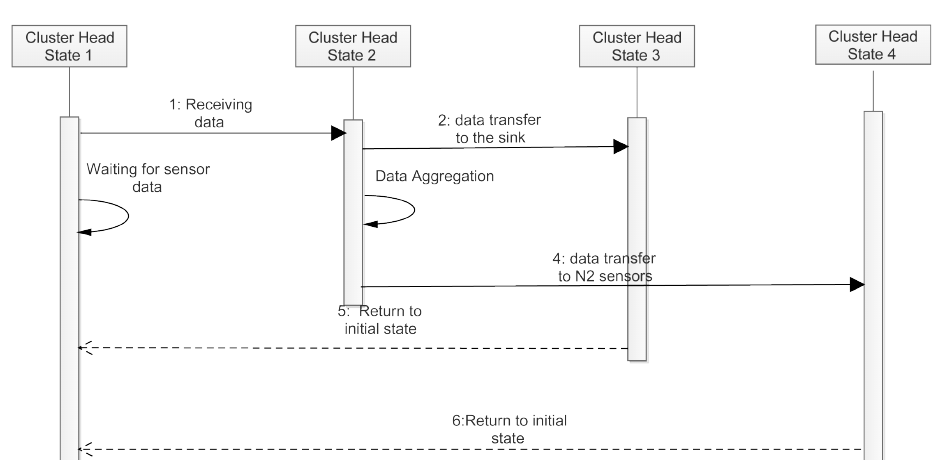
Figure 6. Diagram of activity sequences of clusters at the first level of the